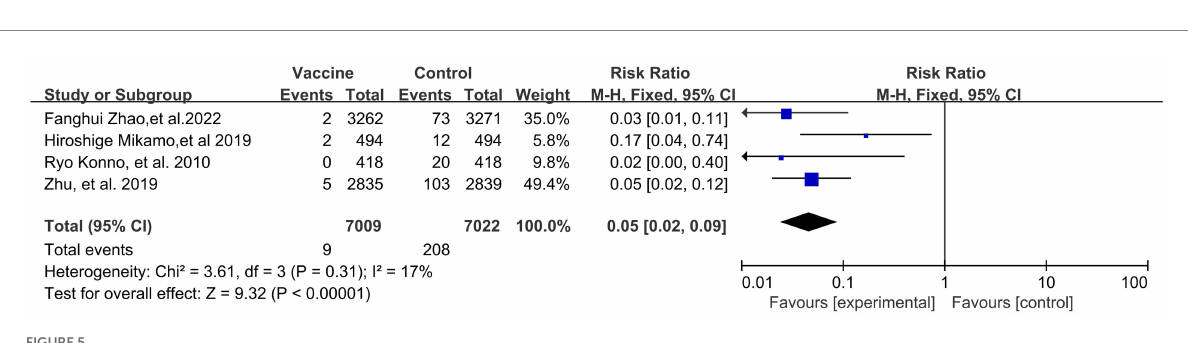
FIGURE 5 A forest plot of the meta-analysis of the incidence of HPV 16/18 associated 6-month persistent infection after HPV vaccination.